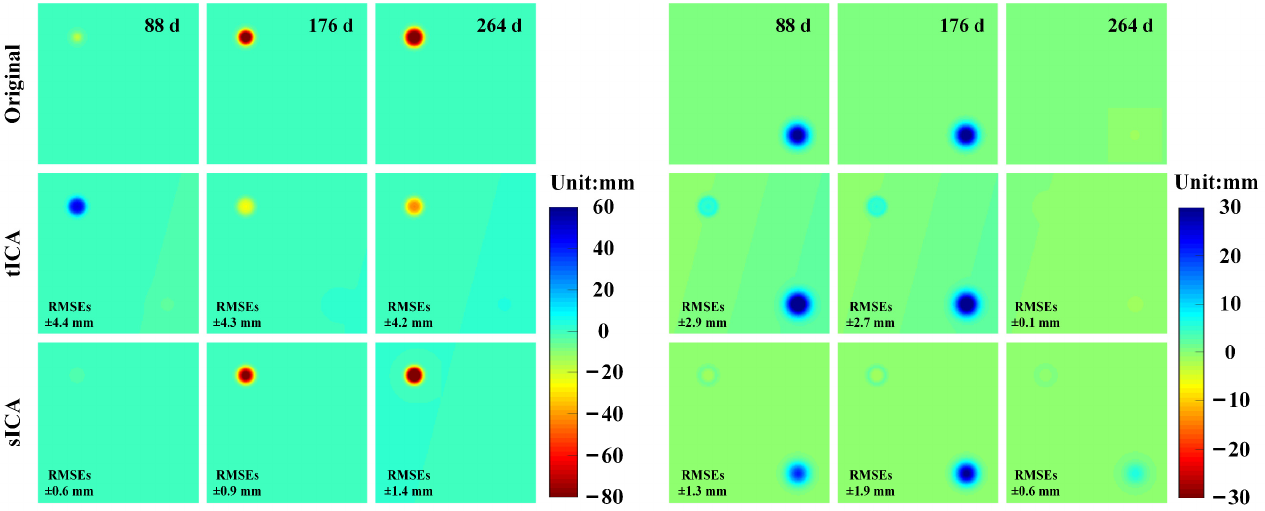
Figure 2. Comparison of the separated results of tICA and sICA at each temporal date ( left : Poisson ‐ related components; right : periodical deformation components).